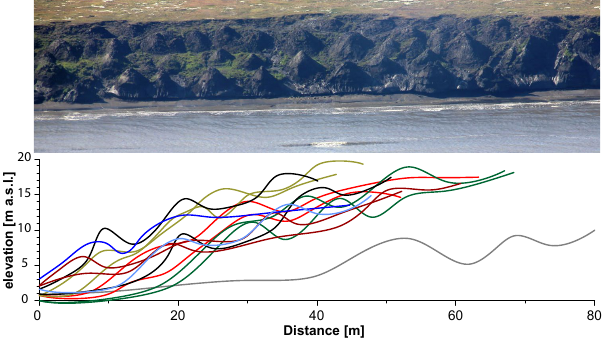
Figure 7. Top: photograph of a baydzharakh field on the east coast of Muostakh Island. Bottom: examples of slope profiles across bay- dzharakhs, showing differences in baydzharakh spacing. wedge axes (Are, 1988b), implying that an exposed wall